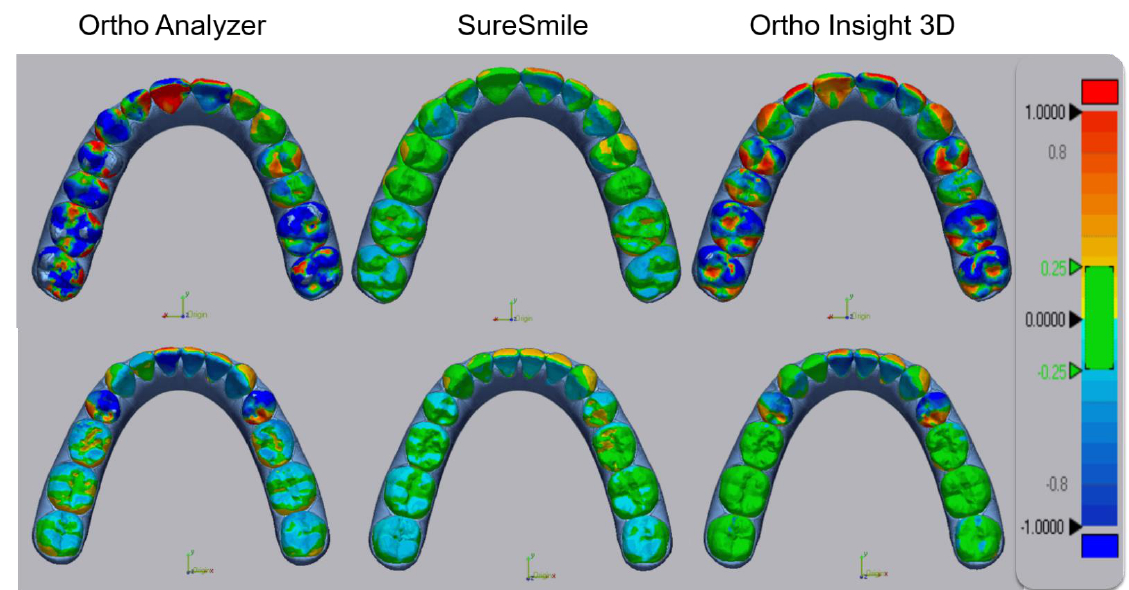
Figure 1. Replicated virtual setups from ClinCheck ® Pro, Ortho Analyzer ® , SureSmile ® , and Ortho Insight 3D ® .